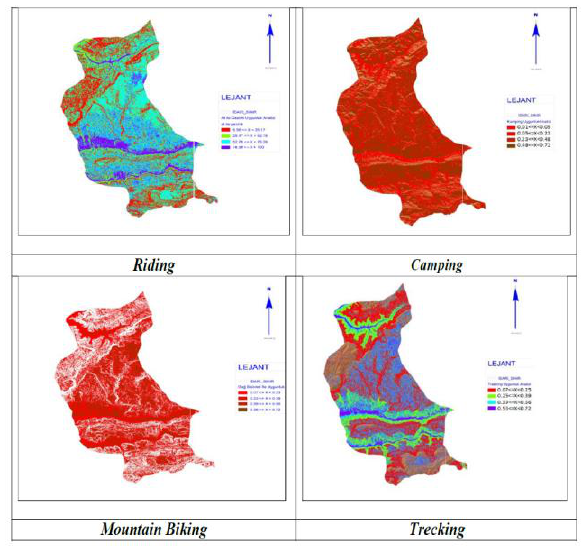
Figure 1. Alternative Tourism Places in